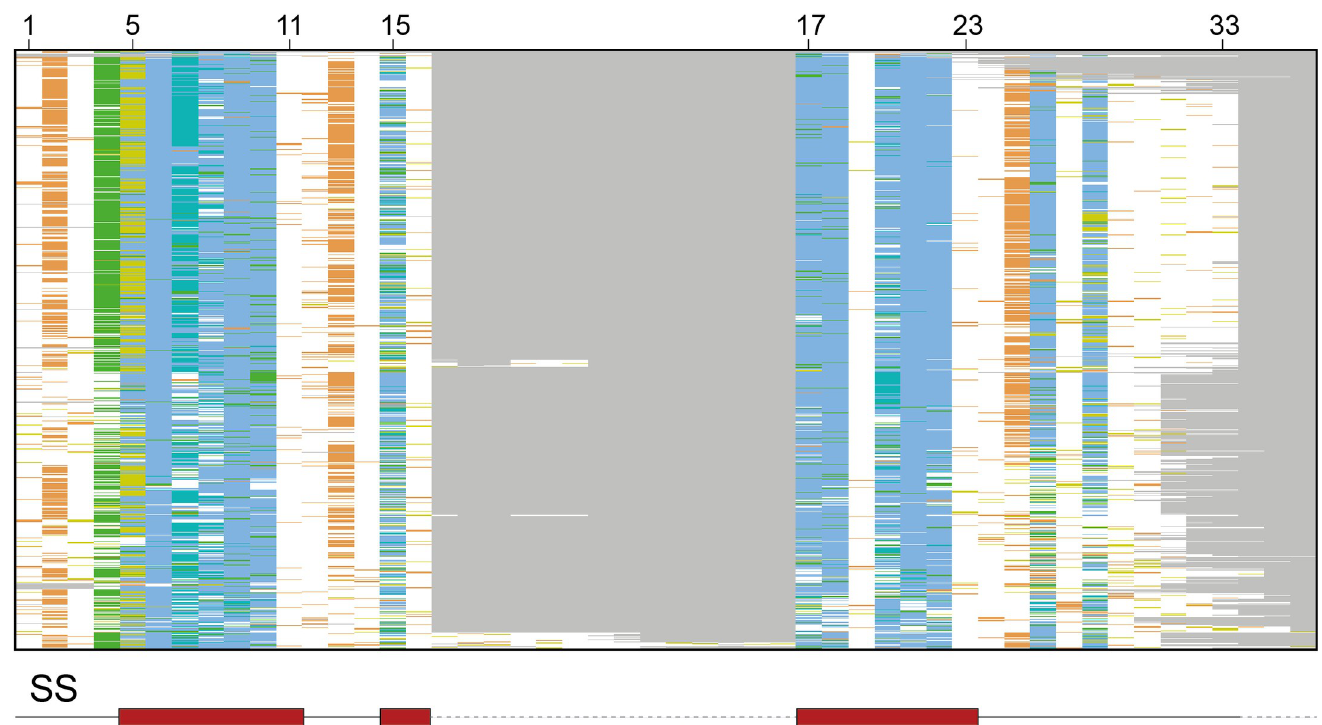
Fig 4. Overview of the resulting MSA, including the 7,404 ankyrin repeat sequences. Only columns with occupancy > 0.5% are shown. Sequences are sorted by a tree generated in Jalview using the average distance method and the BLOSUM62 matrix. Columns between 16–17 and after 33 represent insertions in some ankyrin repeats. Red boxes below the overview indicate the location of the secondary structure elements (SS), α -helices in this case, within the alignment. Grey dashed lines represent gaps and are mostly found at low-occupancy columns. Columns are coloured according to the ClustalX colour scheme [34]. Hydrophobic residues are coloured in blue, glycines in orange, prolines in yellow, polar residues in green and unconserved columns are coloured in white. Obtained with Jalview [35].